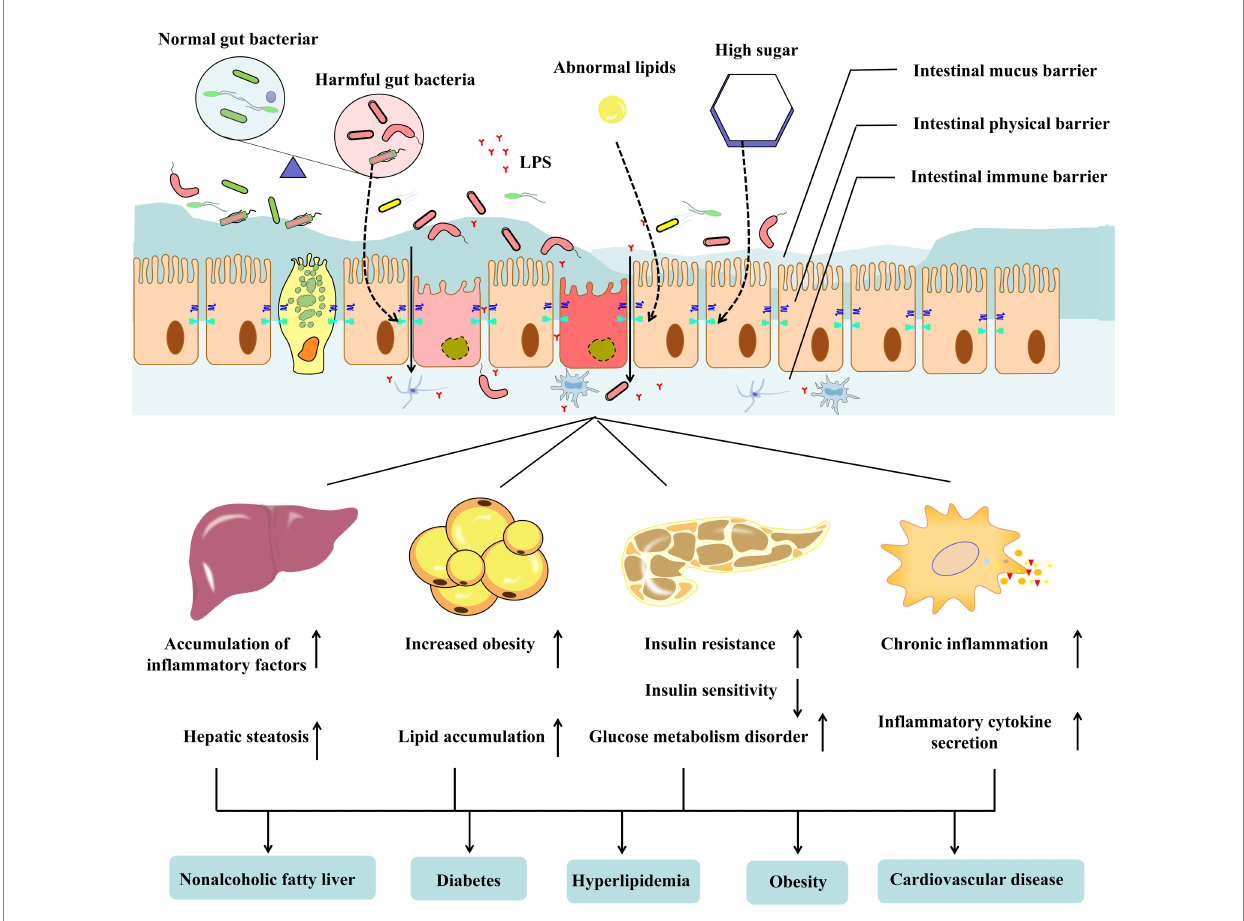
FIGURE 1 The gut barrier consists of gut commensal microbes, mucus, and immune cells in the intestinal epithelium and lamina. Metabolite disorders (hyperglycemia and abnormal lipids) and metabolic diseases, including obesity type 2 diabetes mellitus (T2DM) and non-alcoholic fatty liver disease (NAFLD), lead to gut dysbiosis and disrupt the integrity of the gut barrier. Harmful bacteria or lipopolysaccharides in the intestine enter the blood through the damaged intestinal barrier. It can affect the tissues and organs related to metabolic diseases, resulting in abnormal liver, adipose tissue, pancreas, and immune system functions, aggravating the occurrence and development of metabolic diseases